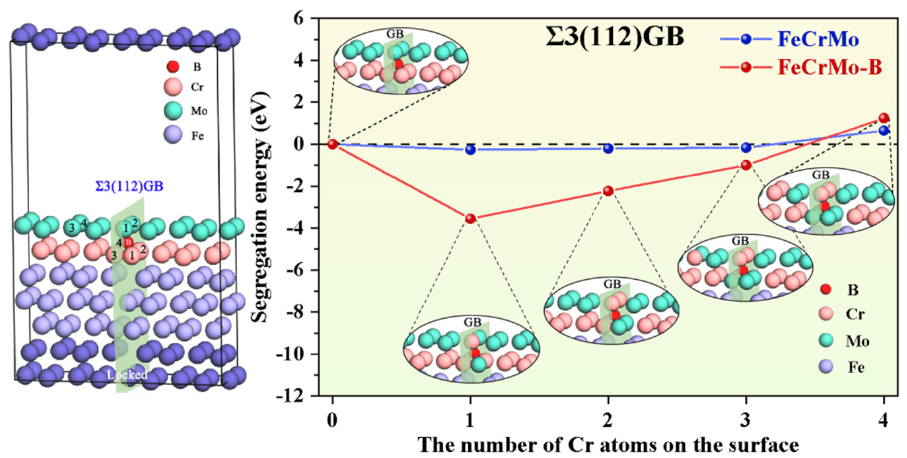
Figure 8. Microstructural models of FCC–FeCrMo(–B)(111) with a Σ 3(112) GB and the segregation energy of Cr diffusion to the surface.